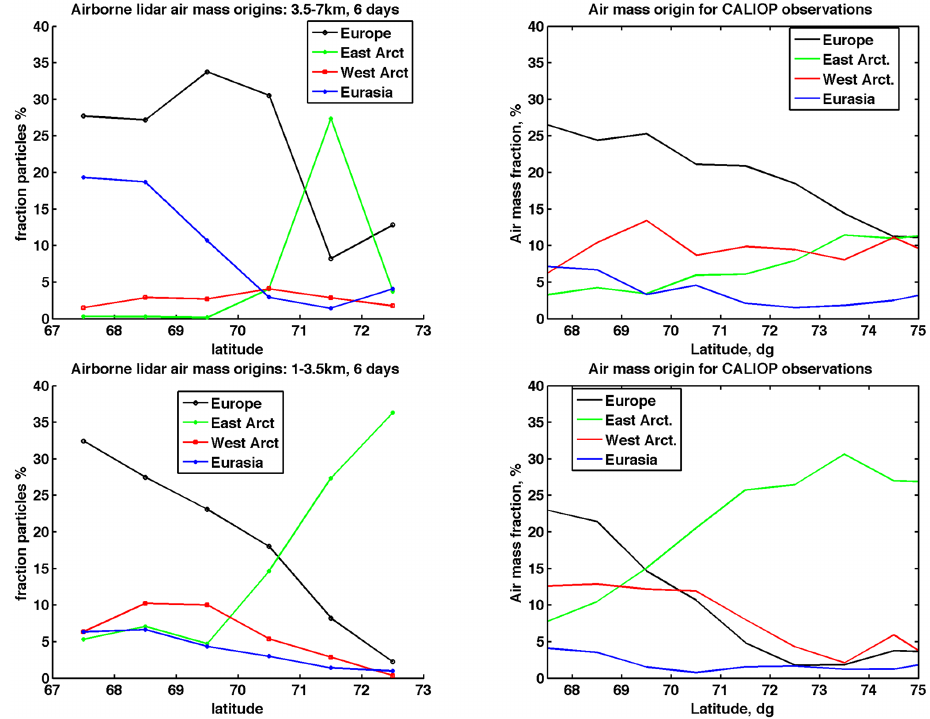
Figure 5. Latitudinal distribution of the fraction of observations corresponding to different air mass origins calculated with FLEXPART for the airborne lidar (left column) and CALIOP observations (right column) at altitudes < 3km (bottom row) and between 3 and 7km (top